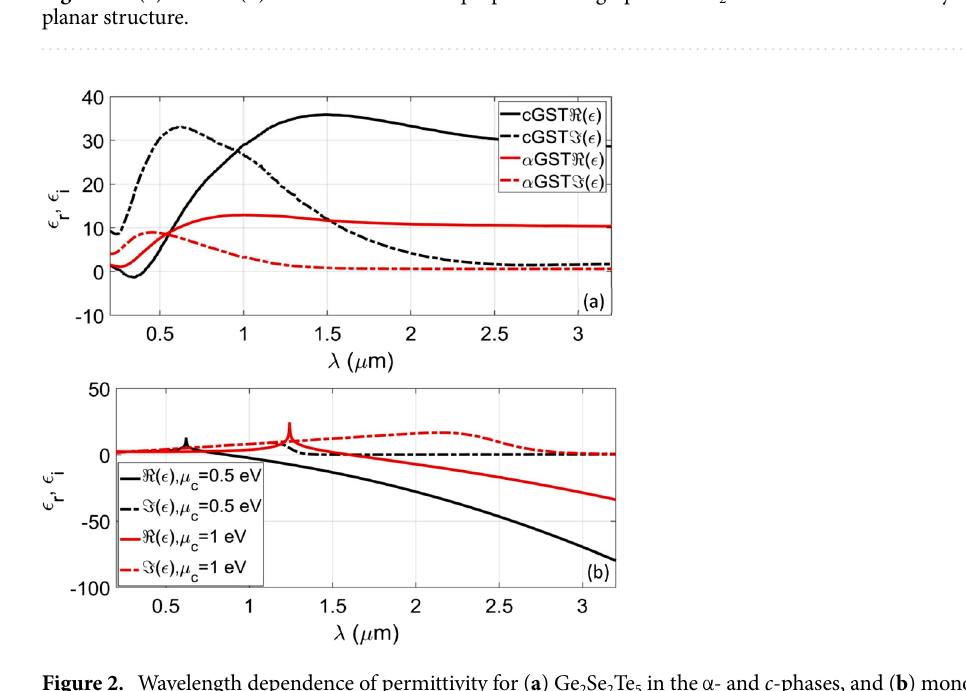
0.5 eV and µ c 1.0 = =